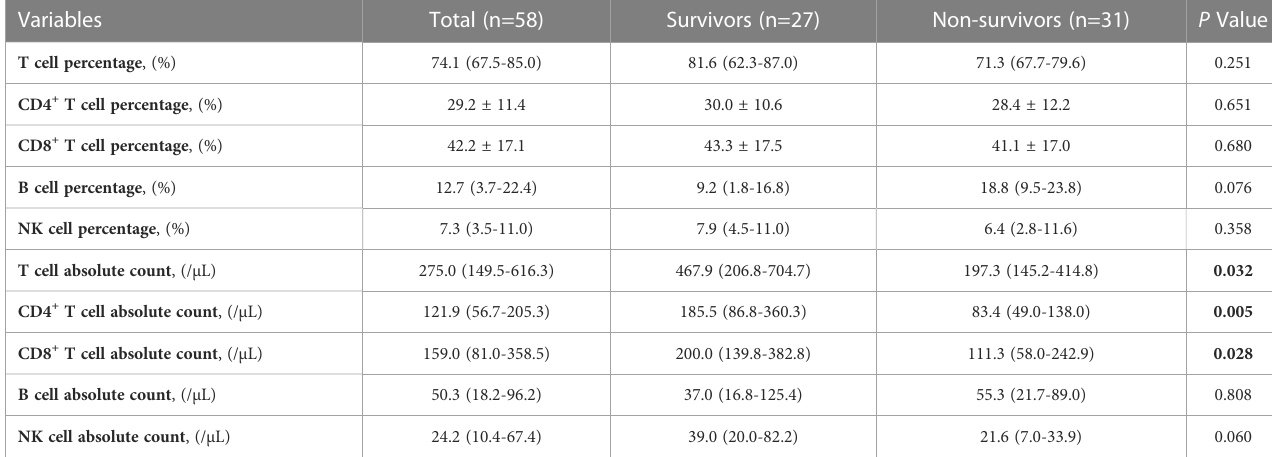
TABLE 2 Immunocytological indices in SLE patients with co-infection.